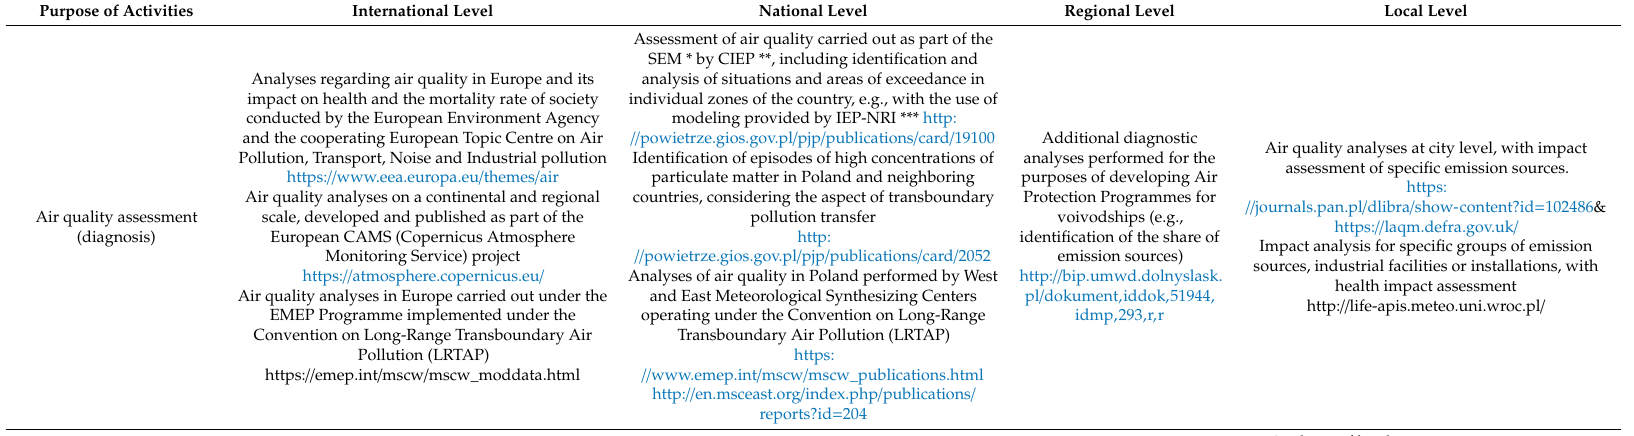
Table 1. Examples of the use of modeling techniques at various levels for the purposes of achieving the main objectives of air quality management with particular emphasis on the area of